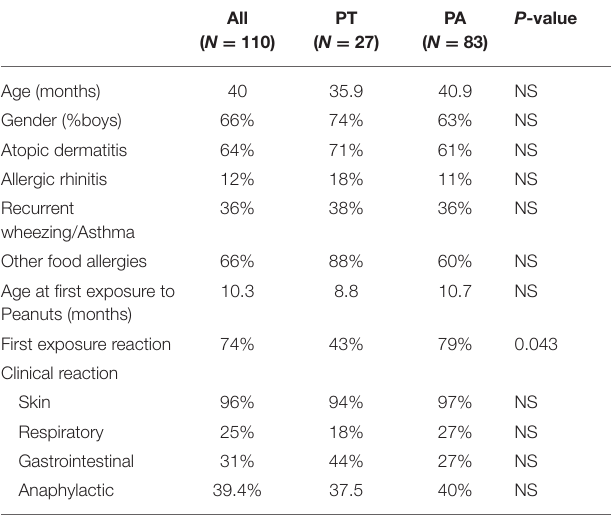
TABLE 1 | Demographics and clinical presentation of 110 preschool children previously diagnosed with IgE mediated peanut allergy.